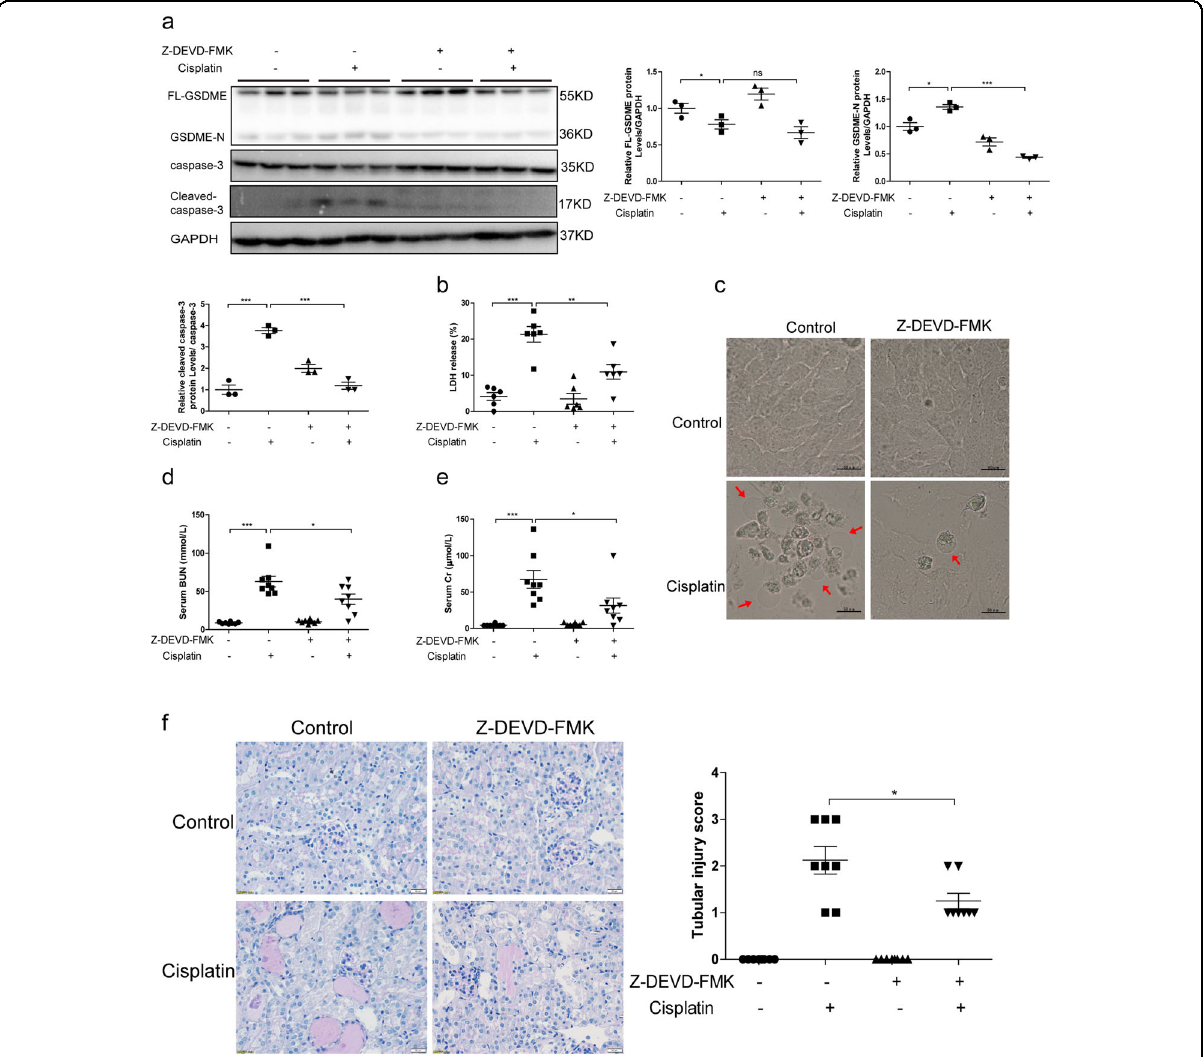
Fig. 7 Caspase-3-speci fi c inhibitor Z-DEVD-FMK relieved cisplatin-induced renal tubular cell injury and pyroptosis. Human TECs (HK-2) and mouse kidney tissues subjected to Z-DEVD-FMK were used to determine the role of caspase-3 in GSDME cleavage and AKI progression. a Protein levels of FL-GSDME, GSDME-N, caspase-3, and cleaved caspase-3 detected by immunoblotting ( n = 3). b Effect of Z-DEVD-FMK on LDH release ( n = 6). c Representative bright- fi eld microscopic images (scale bar = 50 μ m) of cells. Red arrowheads indicate large bubbles from the plasma membrane. d Serum BUN of AKI mice subjected to Z-DEVD-FMK ( n = 8). e Serum Cr of AKI mice subjected to Z-DEVD-FMK ( n = 8). f PAS staining (scale bar = 50 μ m) and associated renal tubular injury score of mice administered with daily injection of Z-DEVD-FMK ( n = 8). * P < 0.05, ** P < 0.01, and *** P <